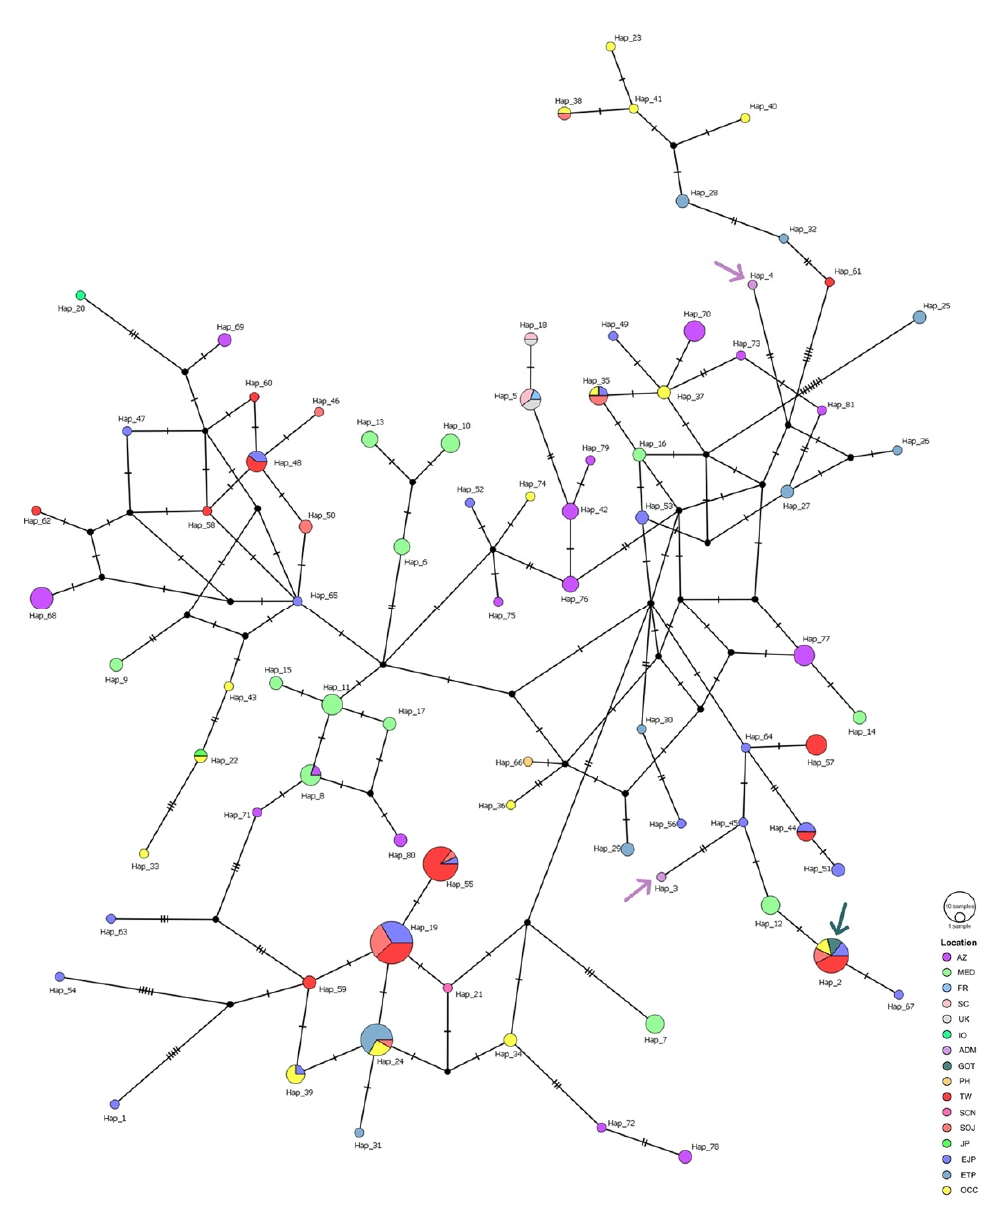
Figure 3. Median joining network (MJN) of all Risso’s dolphin mtDNA control region haplotypes. The MJN was generated from 390 base pairs of Risso’s dolphin mtDNA control region sequences and indicated that 81 haplotypes were found in 16 locations. Each haplotype is colored by location and the small black circles represent inferred haplotypes (not sampled). The size of each circle is proportional to its haplotype frequency, while nucleotide substitutions are shown at the branches as small transverse bars. Purple arrows indicate the haplotypes from the Thai Andaman Sea and the green arrow indicates the haplotype from the Gulf of Thailand. Abbreviations for location are as follows: AZ, Azores Island; MED, Mediterranean; FR, France; SC, Scotland; UK, United Kingdom; IO, Indian Ocean; ADM, Thai Andaman Sea; GOT, Gulf of Thailand; PH, Philippines; TW, Taiwan; SCN, Southeastern China Sea; SOJ, Sea of Japan; JP, Japan; EJP, Eastern Japan; ETP, Eastern Tropical Pacific Ocean; OCC, Oregon-California Coastal.